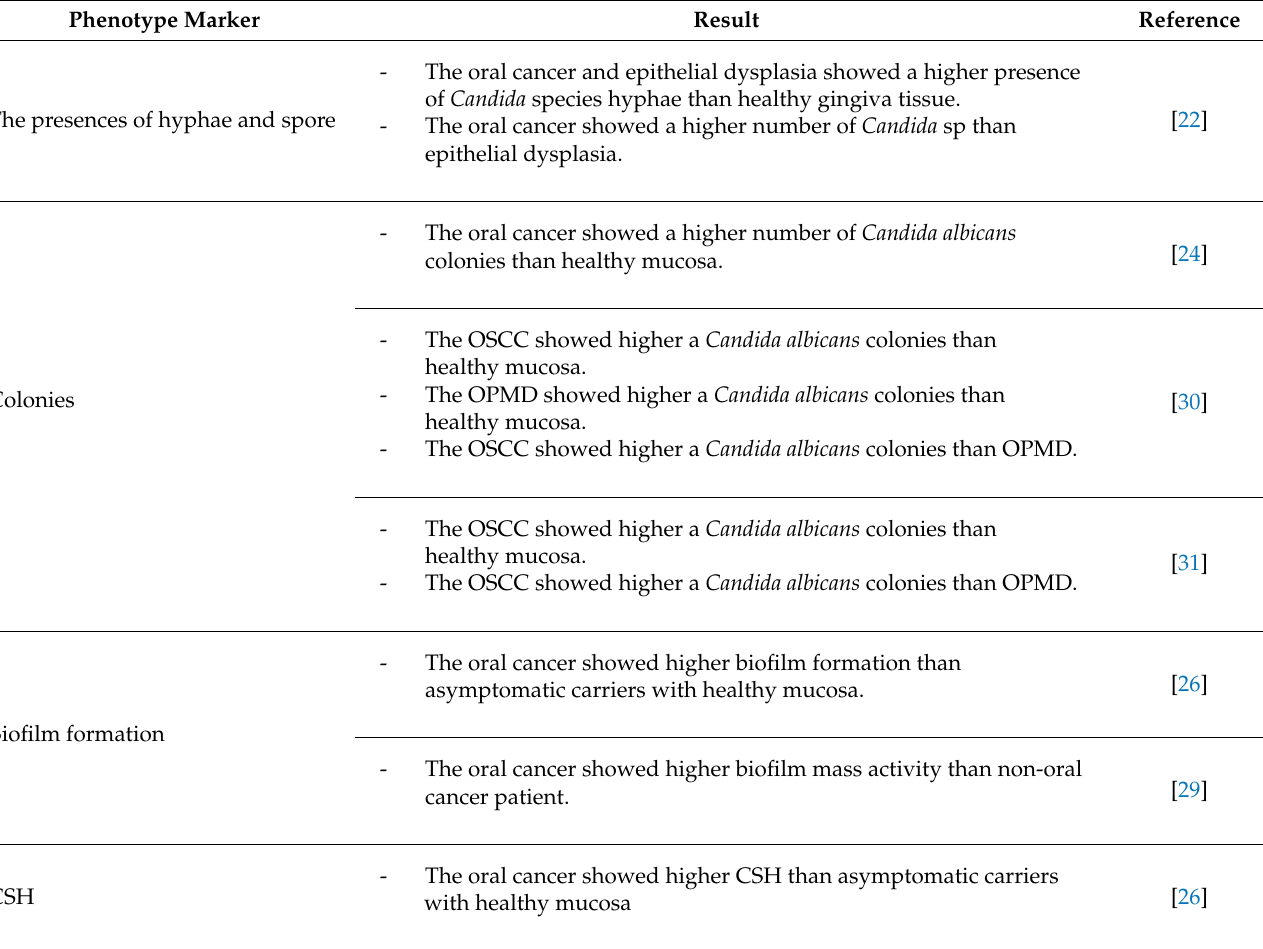
Table 3. The Candida albicans phenotype identified in each